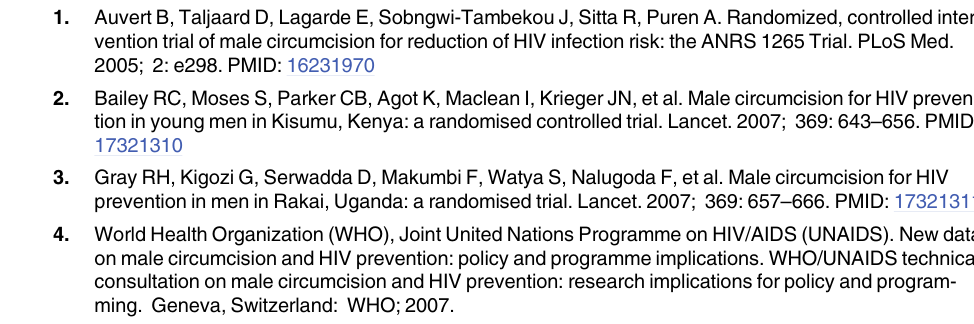
S3 Fig. Magnitude of impact: total HIV infections averted by age-specific scale-up strategy, 2015 – 2029. This figure illustrates the magnitude of impact, or the total number of HIV infec- tions averted by each age strategy. In contrast with the previous figure, S3 Fig depicts more realistic scenarios, in which circumcisions are not limited to specific five-year age groups but are scaled up to 60% coverage across wider combined age groups. The most impactful scenario would be one in which most clients are circumcised: the 10- to 49-year-olds scenario. Error bars represent lower and upper uncertainty bounds as described in [17]. S4 Fig. Cost per HIV infection averted by age-specific scale-up strategy, 2015 – 2029. This figure compares the cost per HIV infection averted in each indicated scenario. As in S3 Fig, the scenarios compared here are combined age groups, and they again involve scaling up circumci- sion coverage to 60% of males in each indicated age group. Circumcising 60% of 15- to 49-year-olds would result in a cost of $3,500 per each infection averted. The lowest cost per HIV infection averted is achieved by circumcising males ages 15 – 34. Error bars represent lower and upper uncertainty bounds as described in